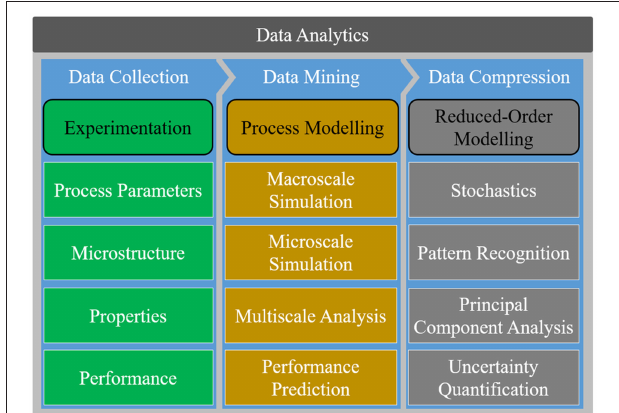
FIGURE 1 | Overview of different data analytics methods applicable within the field of continuums materials mechanics, motivating to develop accurate and comprehensive databases and to make them accessible. Three data sources compose a common data structure: experiments, process models and reduced order models. Experiments lead to empirical determination of characteristics along the p-s-p-p chain. With process models, these characteristics can be described and predicted. Via reduced order models, data can be compressed and patterns recognized. Available data can be analyzed via data mining and machine learning to generate new knowledge. Own figure based on the idea of Smith et al. (2016).